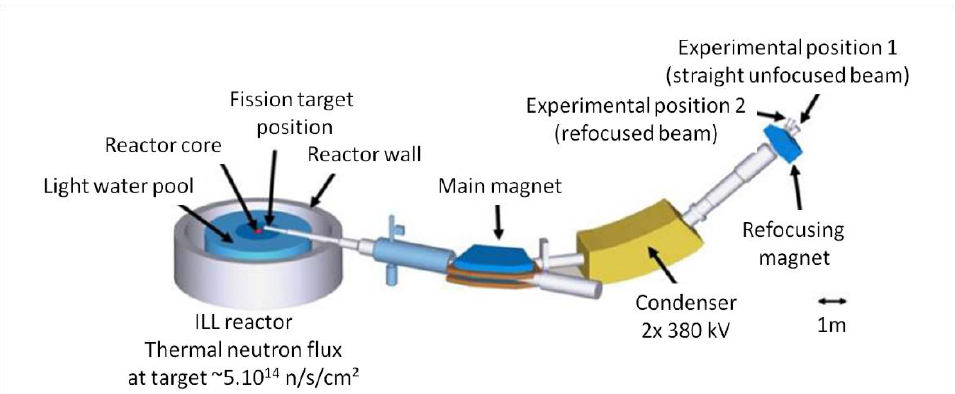
Fig. 1. The LOHENGRIN mass spectrometer at the ILL, Grenoble. The ILL high neutron flux compensates the small geometrical acceptance of the instrument requested for the mass